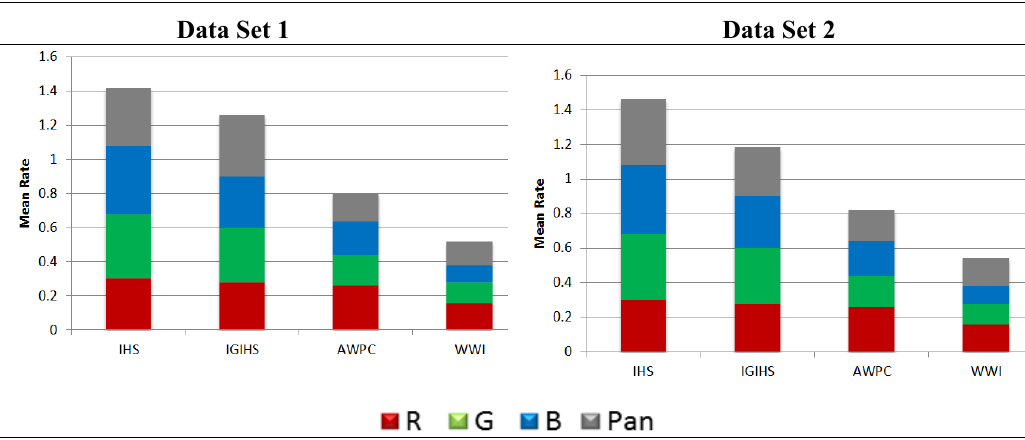
Figure 12. Comparison results of all pan-sharpening methods in both data sets. Data Set 1 Data Set